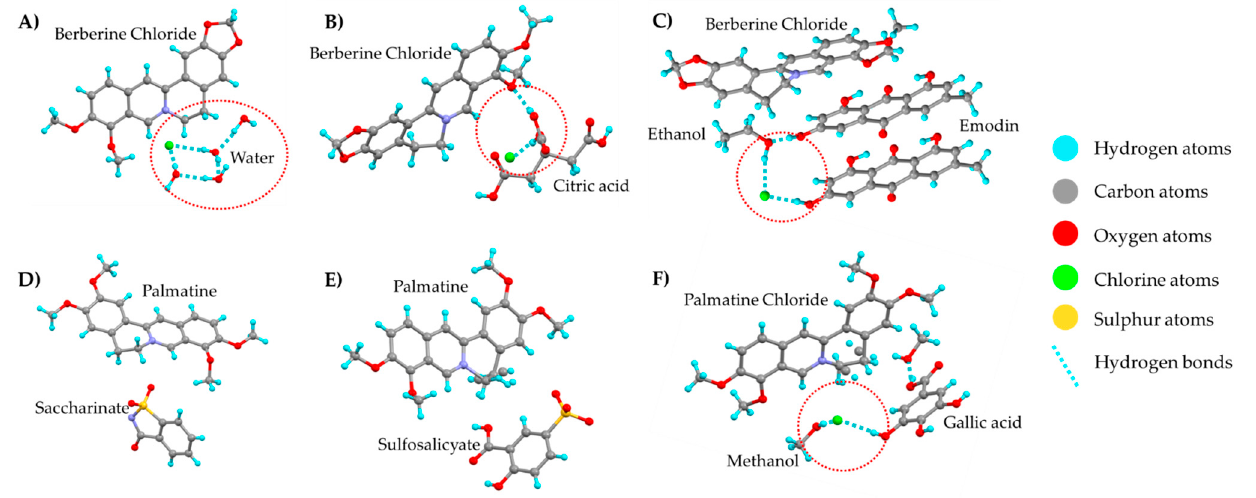
Figure 4. ( A ) Berberine chloride tetrahydrate (#1306671), ( B ) Berberine chloride-citric acid co-crystal (#1857453), ( C ) Berberine chloride-2emodin-ethanol co-crystal (#1862517), ( D ) Palmatine saccharinate salt (#1977091)), ( E ) Palmatine sulfosalicyate salt (#2053643)), ( F ) Palmatine-gallic acid co-crystal (#2075058) (from Mercury 2022.2.0, Build 353591). #—CCDC Identifier